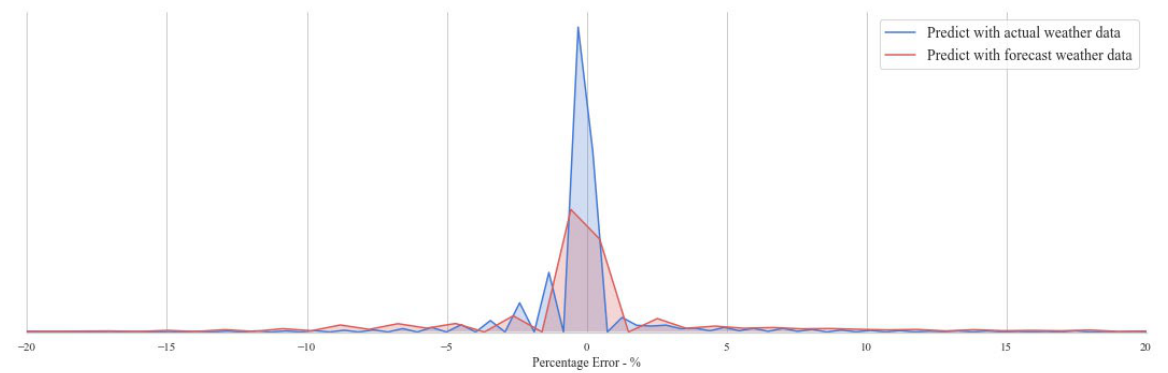
Figure 9. Distribution of Percentage